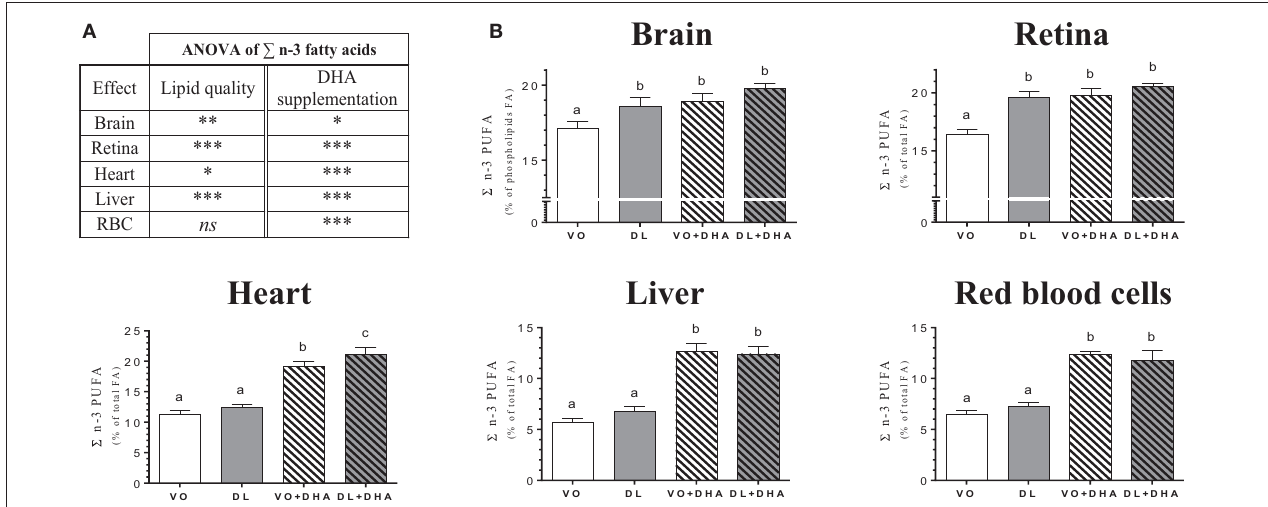
FIGURE 2 | (A) Overall lipid quality (LQ) effect and DHA supplementation (S) effect of the sum of n-3 PUFA (ALA + EPA + DPA + DHA) proportions in brain, retina, heart, liver and red blood cells (RBC) of rats fed the vegetable oil blend diet (VO) or the vegetable oil and dairy lipid blend diet (DL), not supplemented or supplemented with 0.5% DHA (VO + DHA and DL + DHA). The significance of the two effects was assessed by two-ways ANOVA (* p < 0.05, ** p < 0.01, *** p < 0.001). *Represents globally an increase in favor of the DL groups for the LQ effect and in favor of the lots supplemented with DHA for the S effect. ns , not significant. (B) Proportions